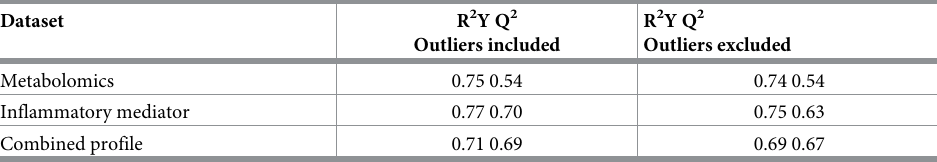
Table 4. Comparison of R 2 Y and Q 2 values calculated for the OPLS-DA models with and without excluding the outliers.